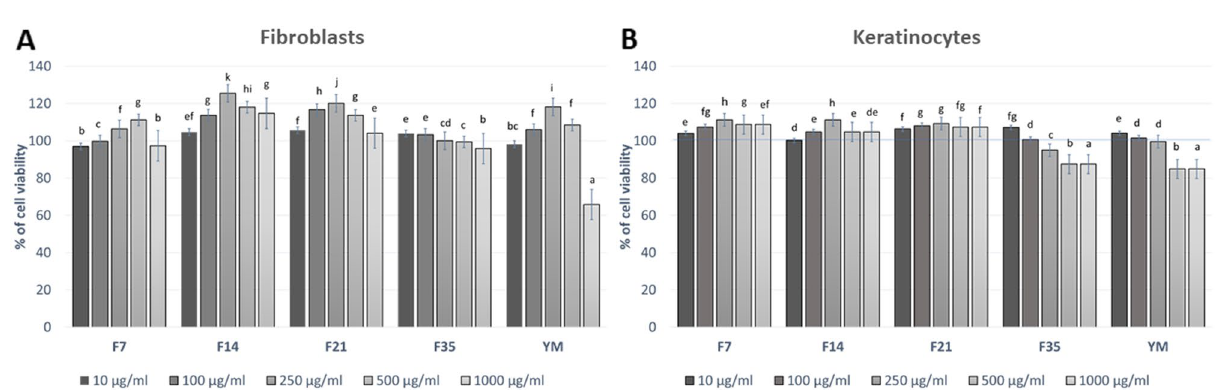
Figure 7. Effect of the increase in the concentration of extract and ferments (10–1000 μg/mL) on cell viability (Alamar Blue assay) by cultured fibroblasts ( A ) and keratinocytes ( B ). Data are the mean ± SD of three independent experiments each consisting of three replicates of each test concentration. Different letters on the charts indicate significant differences between groups ( p <